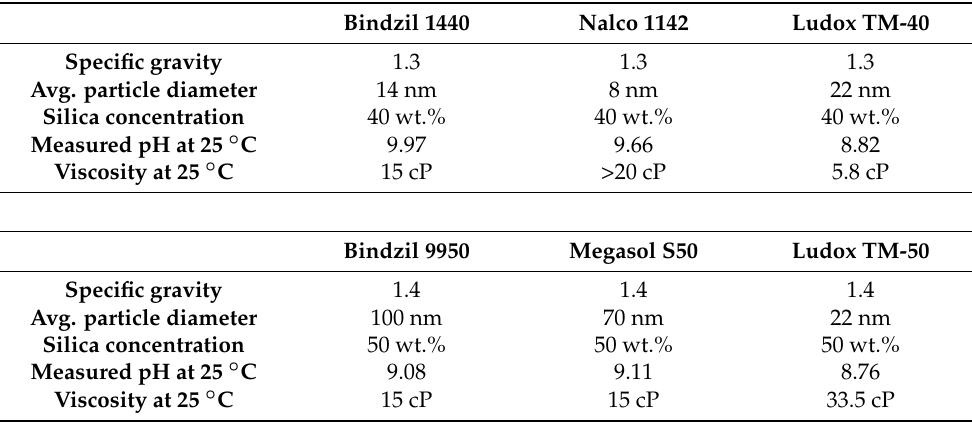
Table 1. Specification information for the types of colloidal silica used